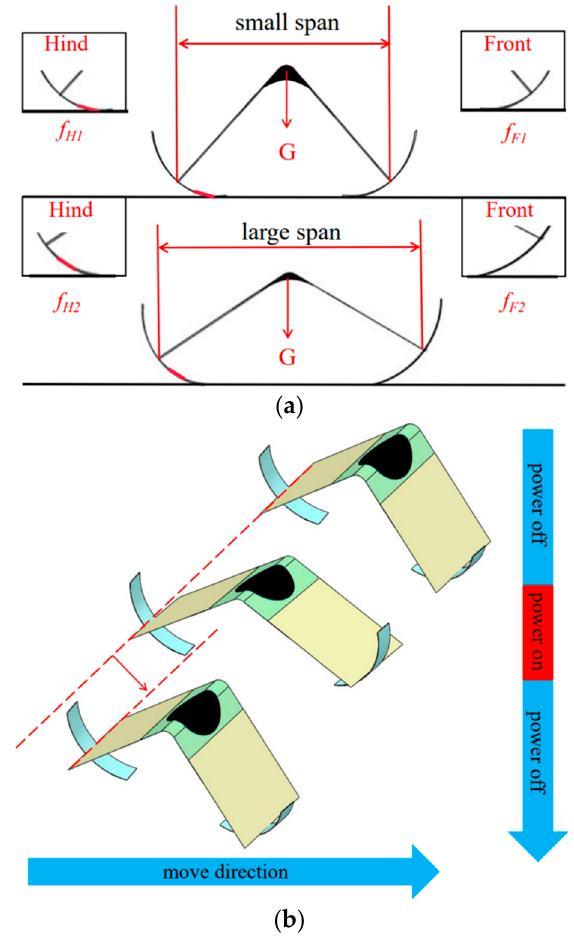
Figure 4. The working mechanism of the feet. ( a ) The working mechanism of friction; ( b ) The movement of the feet.